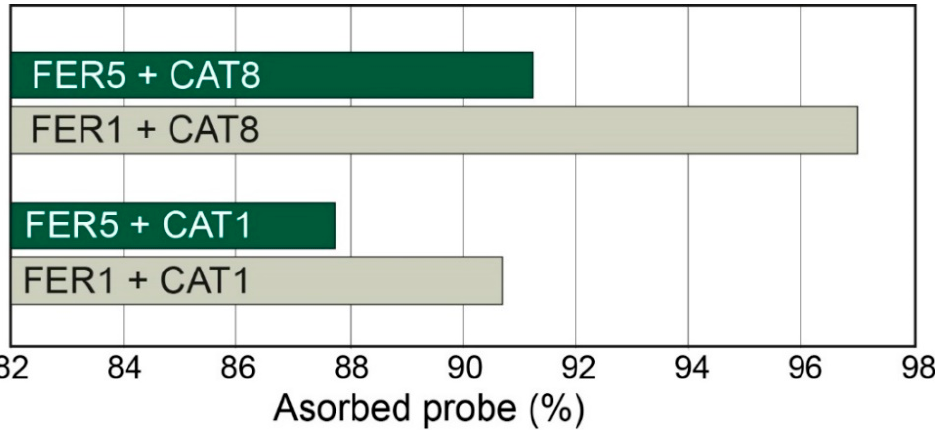
Figure 6. Amount (%) of adsorbed probes in solid FER1 and FER5 ferrierite samples.